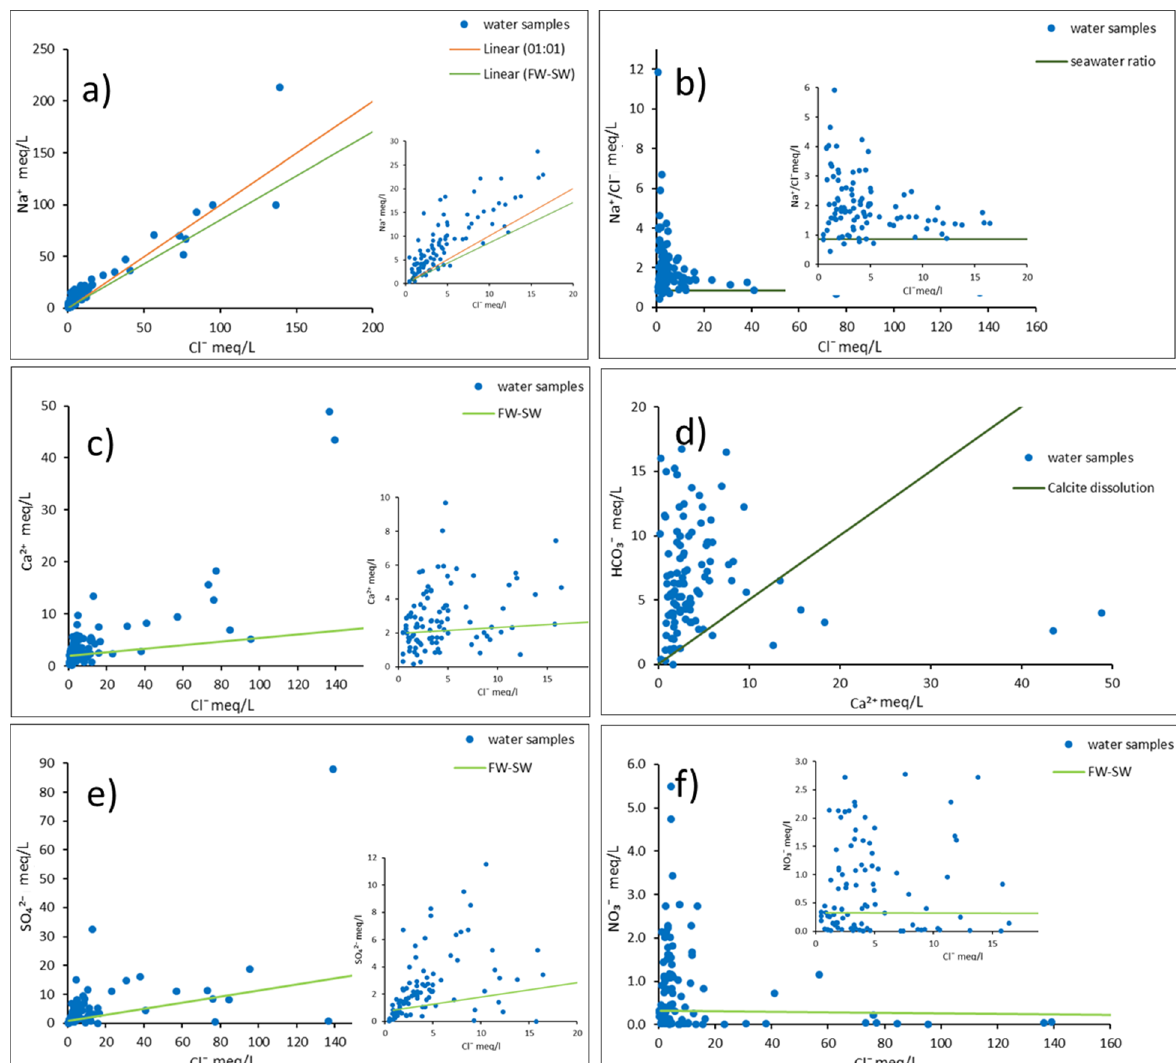
Figure 8. Plots of Na ⁺ ( a ), Ca² ⁺ ( c ), HCO ₃ − ( d ), SO ₄ ² − ( e ) and NO ₃ − ( f ) with respect to Cl − and their ionic ratios ( b ) for groundwater samples.